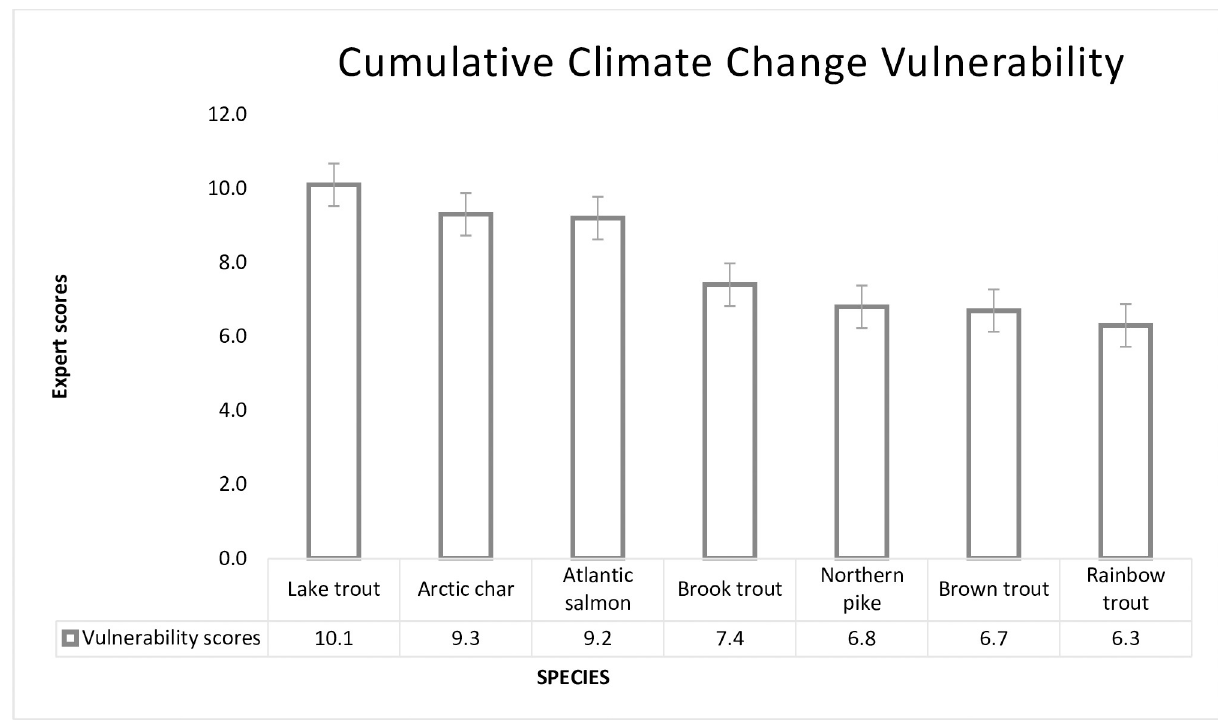
Fig 1. Relative climate change vulnerability scores of selected fishes. The selected fish species are ranked per their relative vulnerability, based on freshwater fish expert’s scoring (n = 8).